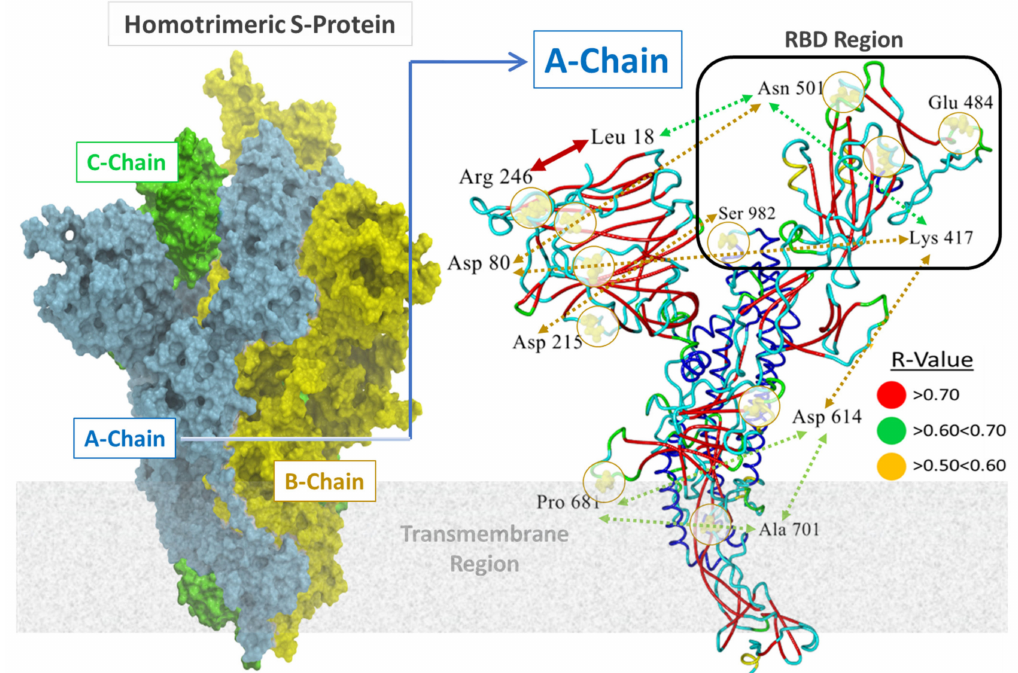
Figure 2. Left Panel : Surface rendition of the homology construct (Template = PDB 6XR8) of the SARS-CoV-2 S-glycoprotein employed in this study. This full-sequence model (SM#05; residues 14–1146) was constructed and refined in (ICM-Chemist_Pro software; Molsoft, LLC) based on the 3D electron microscopic structure found at PDB 6XR8 (SM ID = 6xr8.1) (see https://swissmodel.expasy. org/repository/species/2697049 for details, accessed on 28 April 2022). Sequence similarity was 0.62. The Global Model Quality Estimation value for this model was 0.73, indicative of a high-quality model. Right Panel : Locations of 11 residues of interest in this study (mutation loci) in the A-chain of Homotrimeric S-Protein are indicated. Double-headed arrows indicate residue pairs that were statistically correlated (R > 0.5) in free-energy protein stability calculations averaged over 20 amino acid substitutions at each locus. Higher correlations indicate mutations at each pair locus affect protein stability to a similar magnitude. For example, sites R246 and L18 exhibited the highest correlation (R = 0.87) suggesting the possibility that mutation-driven conformational changes at one site may influence conformation at the other site in a manner that also favors enhancement of S-protein